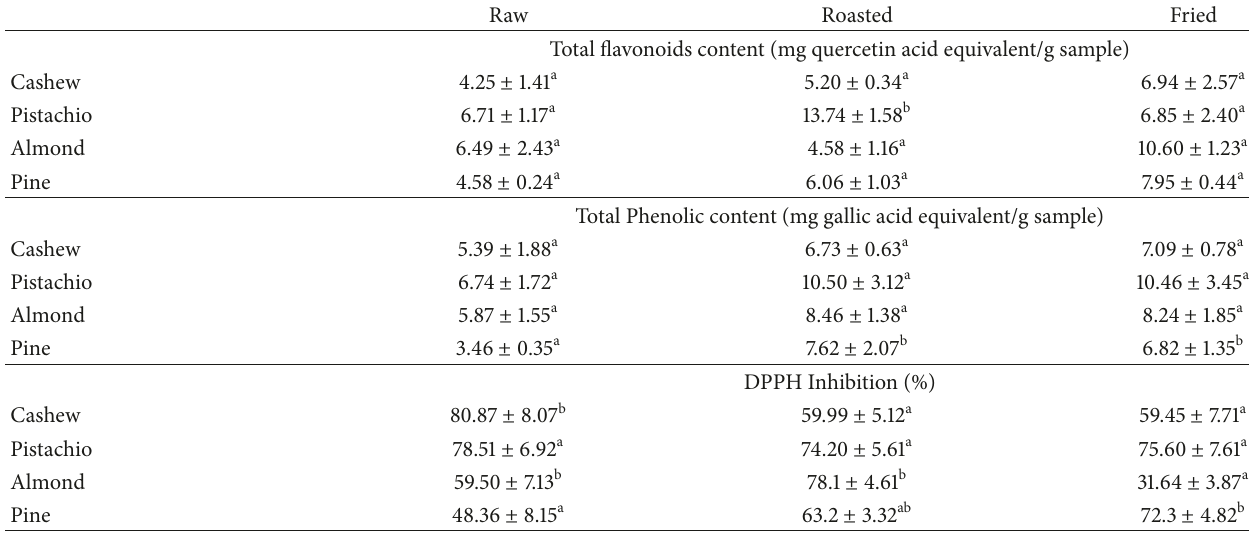
Table 1: Effect of roasting and frying on antioxidant activity as compared to raw